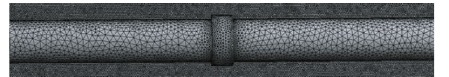
Figure 3: Mesh grid model of the drillstring joint.